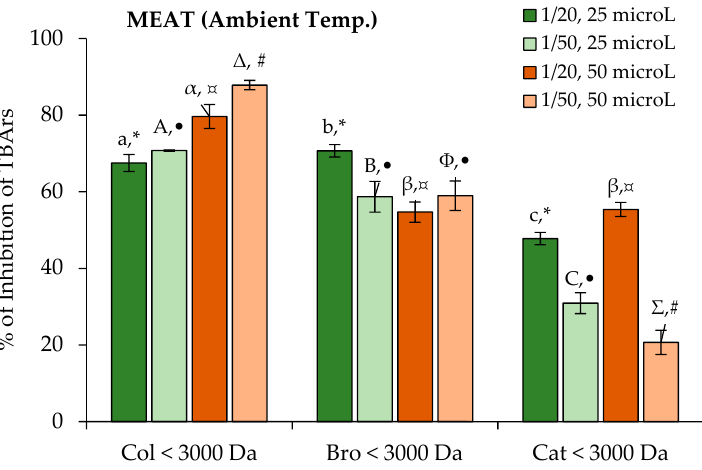
Figure 8. Percentage of inhibition of TBArs in meat at ambient temperature by the peptide-mineral complexes, for the < 3000 fraction, E:C ratio 1/20 and 1/50, peptide-mineral complex volume 25 and 50 µL (Col = collagenase B, Bro = Bromelain, Cat = cathepsine B). Columns label interpretation: (i) lowercase letters indicate differences among enzymes for the 1/20 ratio and 25 µL sample volume; (ii) different uppercase letters indicate differences among enzymes for the 1/50 ratio and 25 µL sample volume; (iii) different lowercase Greek letters indicate differences among enzymes for the 1/20 ratio and 50 µL sample volume; (iv) different uppercase Greek letters indicate differences among enzymes for the 1/50 ratio and 50 µL sample volume; (v) for each enzyme, different symbols indicate differences among ratios and samples volumes .